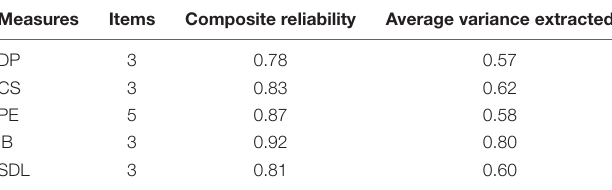
TABLE 2 | Convergent validity of confirmatory factor analysis of the flipped English learning readiness questionnaire. Measures